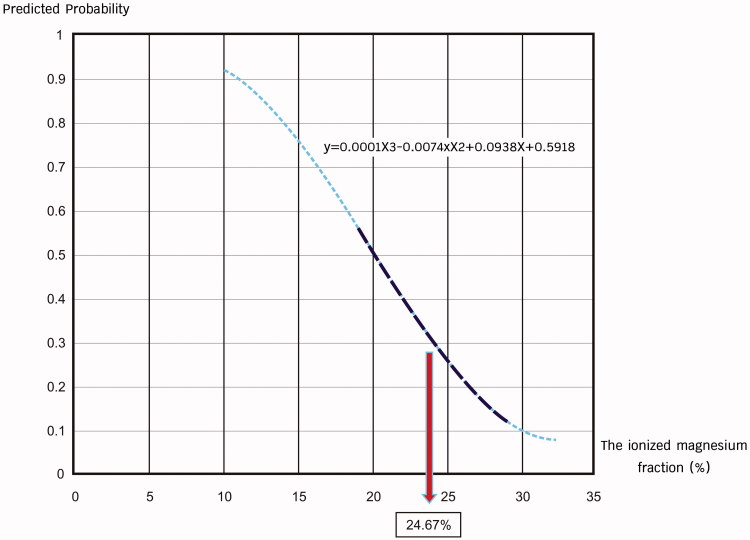
Curve of estimation on disease probability: the graph showed association between the probability of preeclampsia and the ionized magnesium fraction. The maximum slope indicated a cut point value of 24.67%, meaning that patients with ionized magnesium fractions of less than 24.67% were at higher risk of preeclampsia.